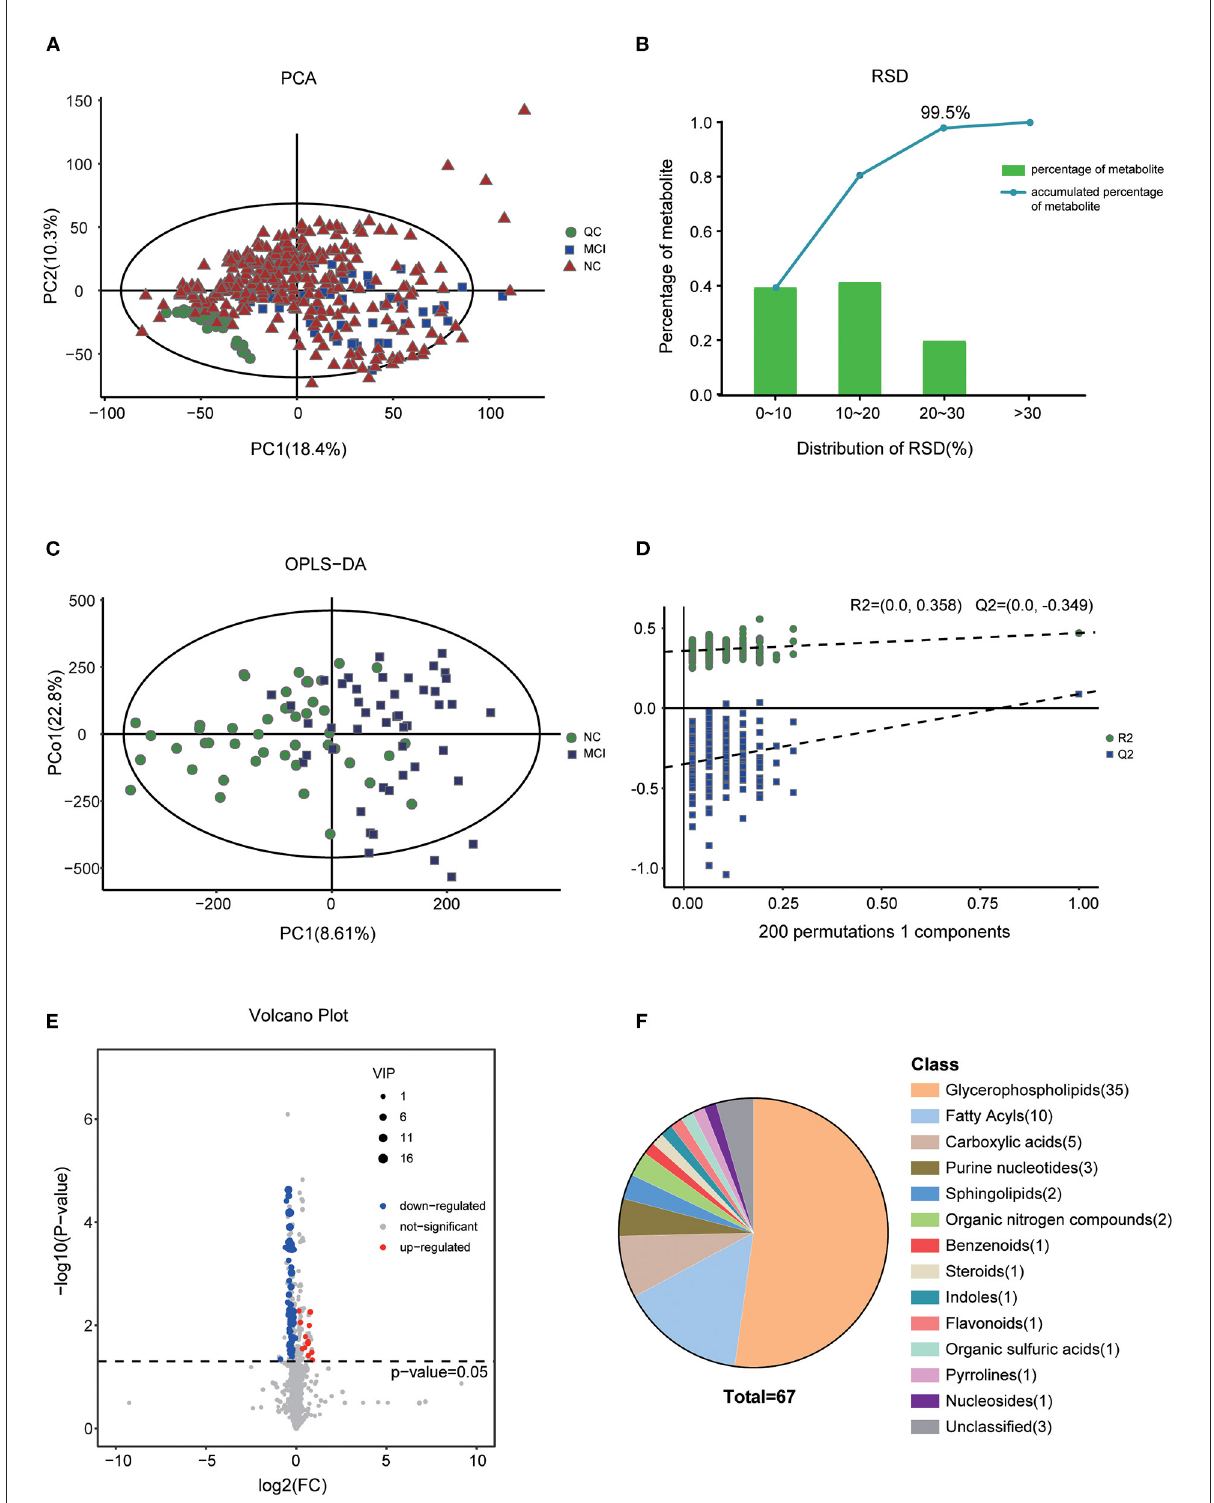
FIGURE1 Altered metabolic profiles in MCI compared with NC. (A) Score plot of PCA in the cohort. (B) RSD distribution of metabolites in QC samples. (C) OPLS-DA score plot of MCI and the matched NC groups. (D) Statistical validation of the OPLS-DA model by permutation testing with 200 iterations. (E) Volcano plot of the differential metabolites filtered by the univariate analysis between the NC and MCI groups. (F) The pie chart shows the classification and number of significantly disturbed